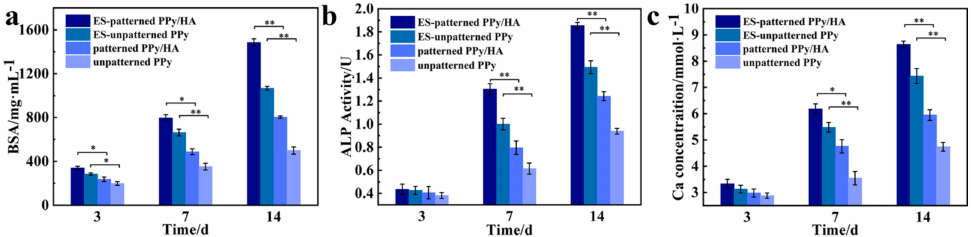
Figure 6. ( a ) BSA protein content of MC3T3-E1 cells cultured on different materials; ( b ) The ALP activities of MC3T3-E1 cells cultured on different materials; ( c ) The inorganic calcium content of MC3T3-E1 cells cultured on different materials. * p < 0.05, ** p <